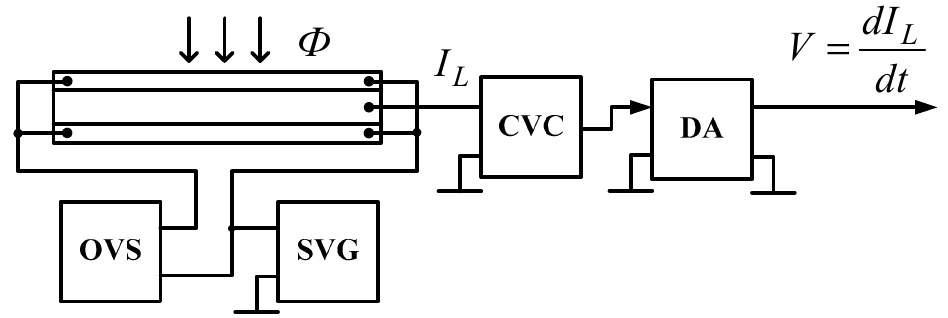
Figure 2. Enabling a multiscan using the traditional “scanistor” scheme.